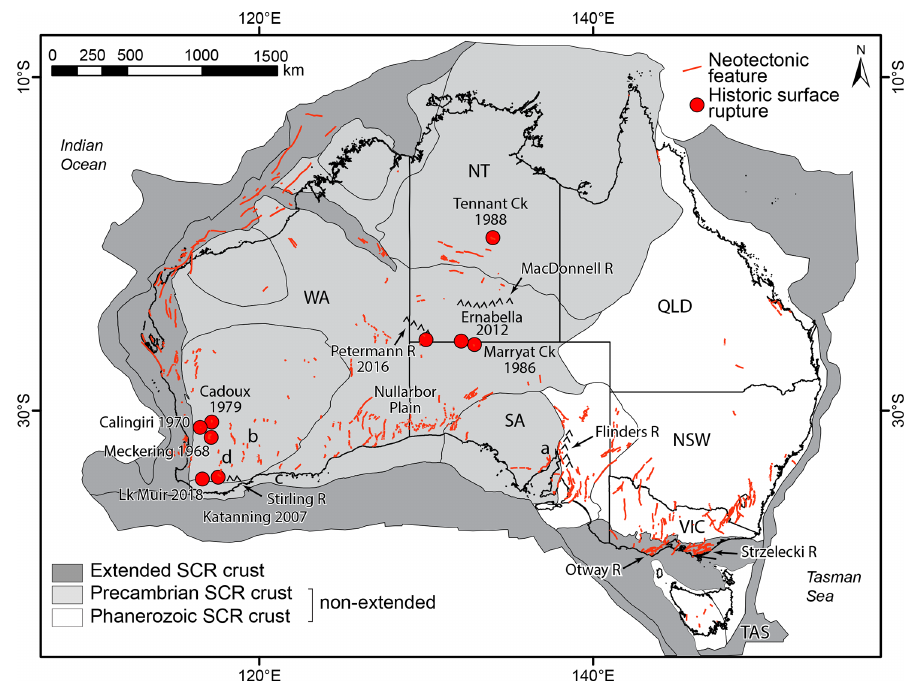
Figure 1. An example of heterogeneity in seismogenic potential within stable continental region (SCR) crust from Australia. Base map shows neotectonic superdomains (after Leonard et al., 2014) and the outlines of Australian states and territories. Neotectonic features (red lines) from the Australian Neotectonic Features Database (Clark et al., 2012; Clark, 2012). Historical surface ruptures shown as red dots labelled with the year of the event. Note all historical surface ruptures have occurred in Precambrian non-extended stable continental region crust (Johnston et al., 1994). Key locations include a: Roopena scarp; b: Hyden scarp, c: Lort River scarp; and d: Dumbleyung scarp.